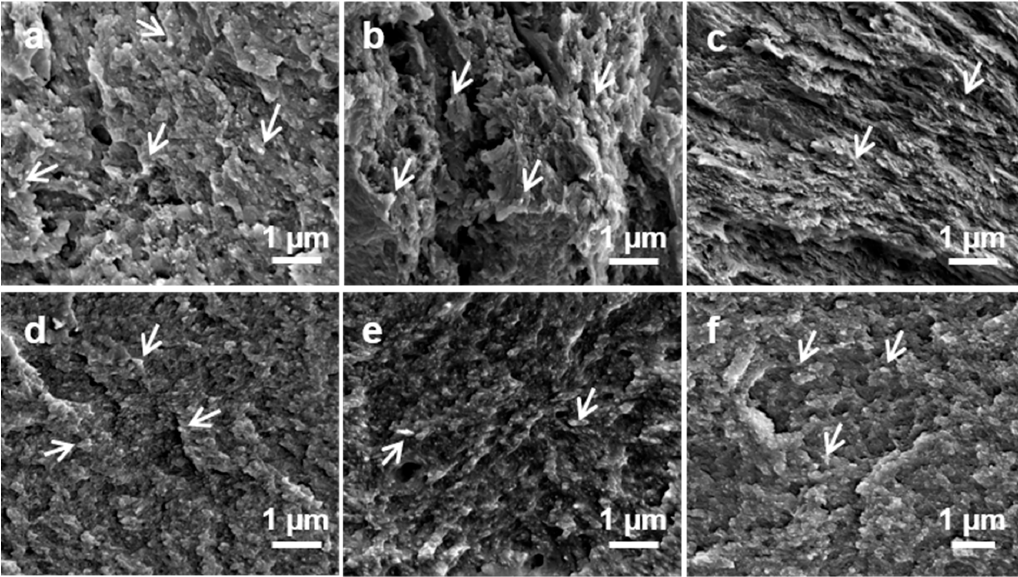
Figure 8. SEM images of fracture surfaces of ( a ) T1F3_CNF, ( b ) T1F6_CNF, ( c ) T1F9_CNF, ( d ) T1F3_CNC, ( e ) T1F6_CNC, and ( f ) T1F9_CNC. (broken and short individual fibre ends are shown with white arrows. All the images were obtained using 20 kx magnification and a 5 kV accelerating voltage.)